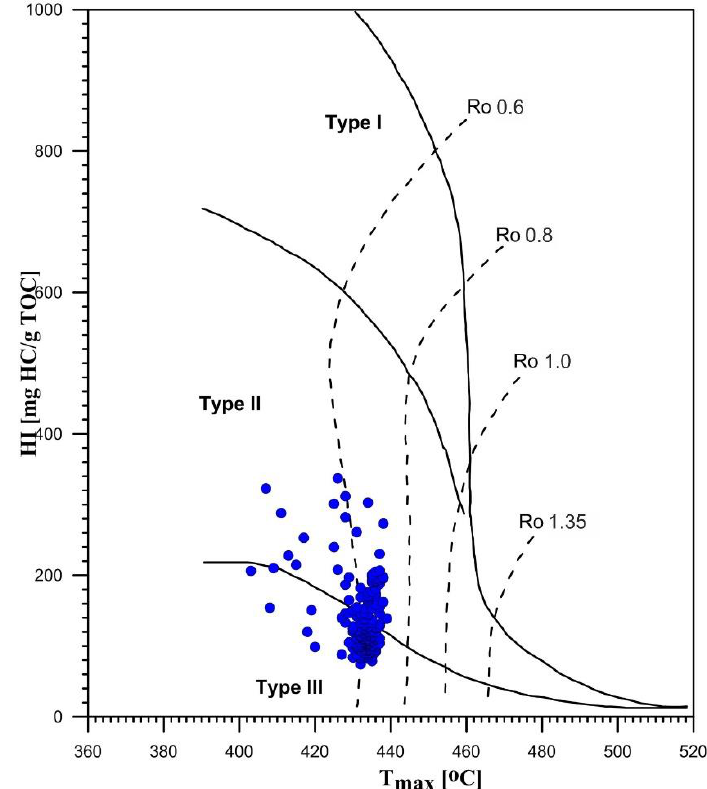
Figure 4. Characterization of organic matter from studied part of Miocene sedimentary basin based on Rock-Eval hydrogen index (HI) versus T max temperature diagram; maturity paths as described by the authors of [51].